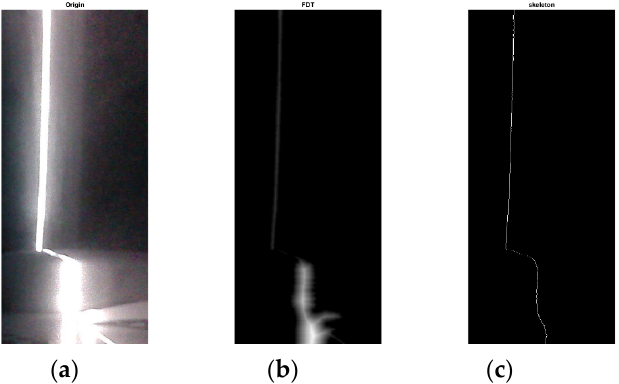
Figure 6. Image pre-processing steps.